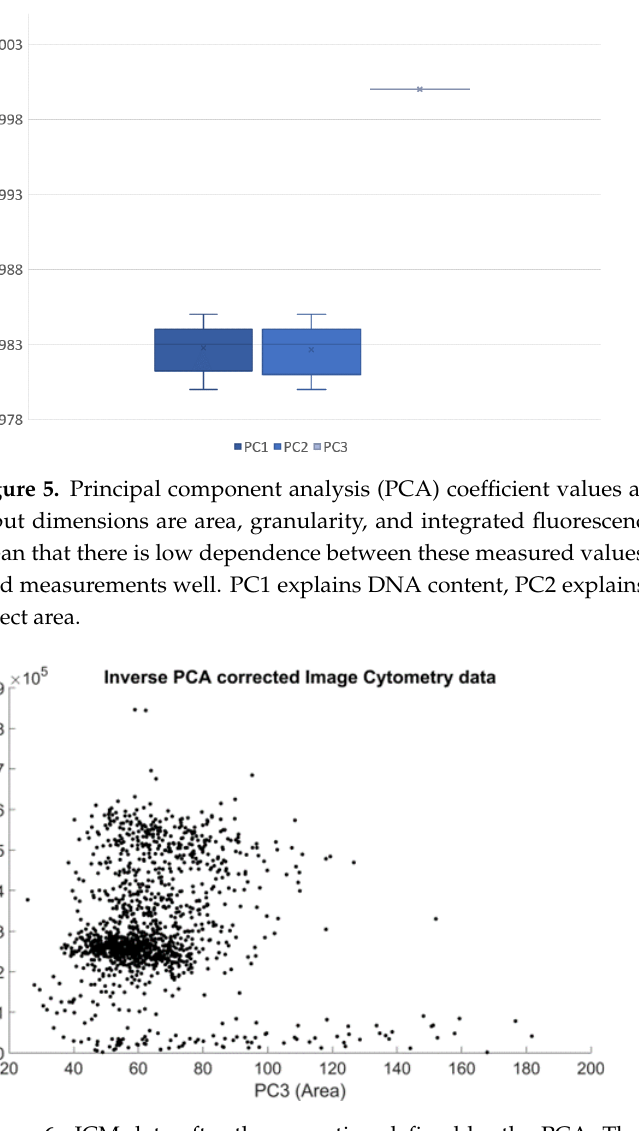
Figure 6. ICM data after the correction defined by the PCA: The resemblance to the FCM data plot (Figure 3) was improved. Each data point represents a cell nucleus, but now in the PC1 – PC3 coefficient plane (representing the underlying, noise-filtered area, and DNA content measurements). The subpopulations of the 2N and 4N peaks are more prominent.